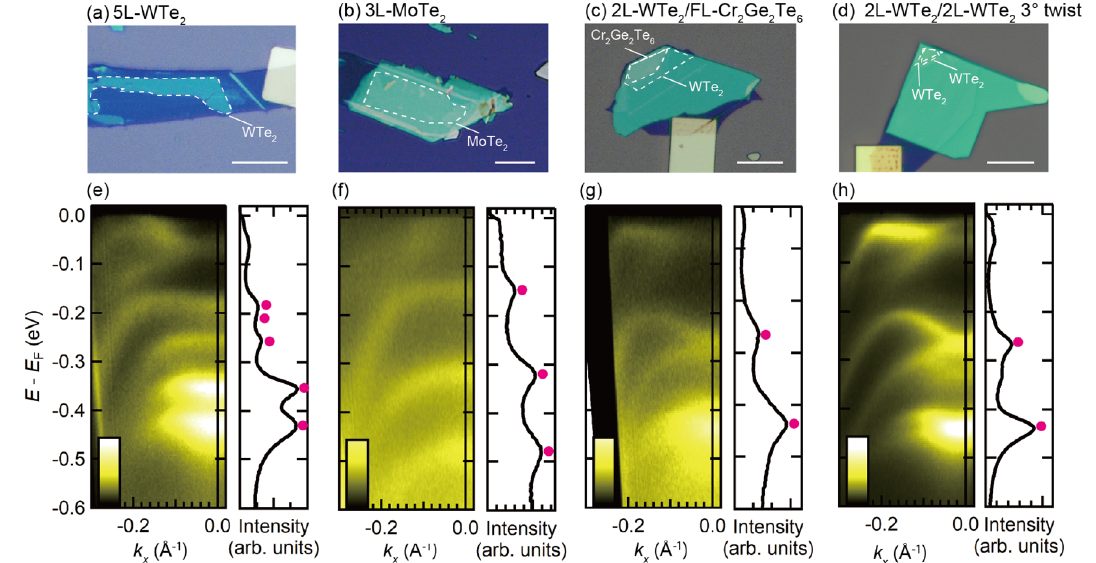
Figure 4. (Upper panels) Optical microscopic images of ( a ) 5-layer WTe 2 , ( b ) 3-layer MoTe 2 , ( c ) 2-layer WTe 2 /few-layer Cr 2 Ge 2 Te 6 , and ( d ) twisted double 2-layer WTe 2 with a rotation angle of 3 encapsulated between monolayer graphene and graphite. The white scale bar corresponds to 10 µ m. (Lower panels) The ARPES images of ( e ) 5-layer WTe 2 , ( f ) 3-layer MoTe 2 , ( g ) 2-layer WTe 2 /few-layer Cr 2 Ge 2 Te 6 , and ( h ) twisted double 2-layer WTe 2 recorded along the k x direction. For the twisted double 2-layer WTe 2 , the k x axis is set to the direction tilted ± 1.5 degrees from the k x axes of the top and bottom 2-layer WTe 2 . Energy distribution curves at k x = 0 obtained with an integral width of 0.04/Å . The red markers indicate the positions of the intensity peaks derived from the topmost WTe 2 or MoTe 2